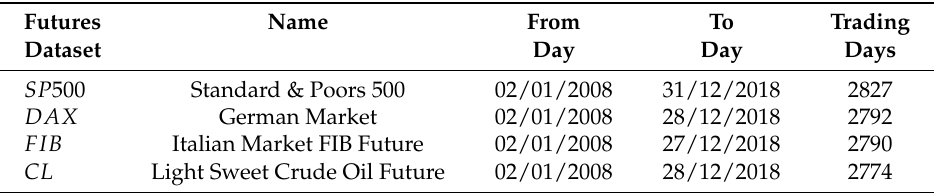
Table 4. Futures Market